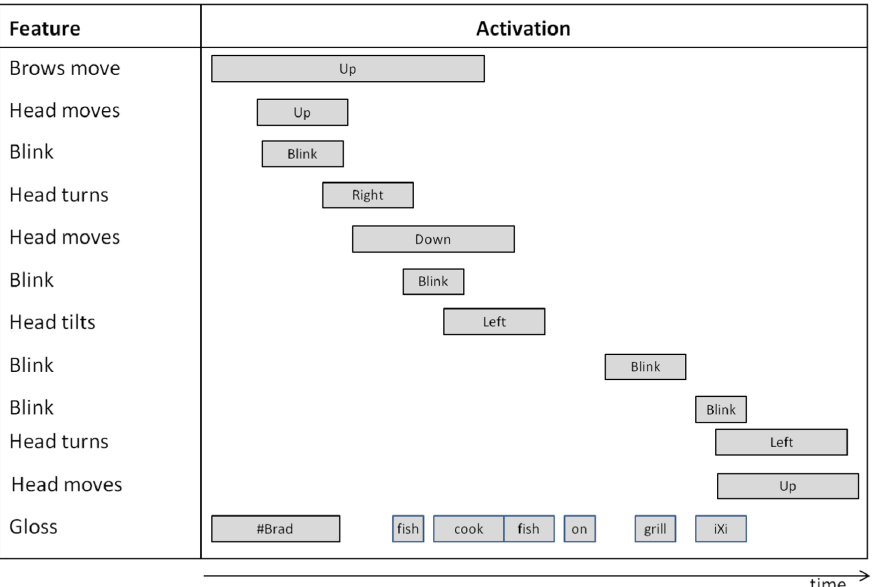
Figure 5. A diagram describing facial feature movements/positions and the gloss for the sentence ‘‘ # BRAD-IXi COOK FISH ON GRILL IXi.’’ For clarity, here, we have listed the events and their time intervals in order of occurrence. The top row specifies the first event, with subsequent rows listing later occurring events. The bottom row summarizes the time interval of each signed concept. This visualization facilitates the coding of the events using the propositions in P . For example, for the figure above, it is easy to see that head moves up occurs during event brows move up , which can be compactly expressed as during ( head moves up, brows move up).